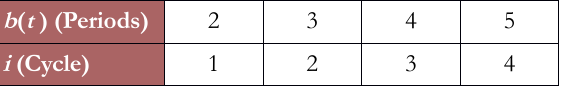
Table 24. Scenarios of sensitivity